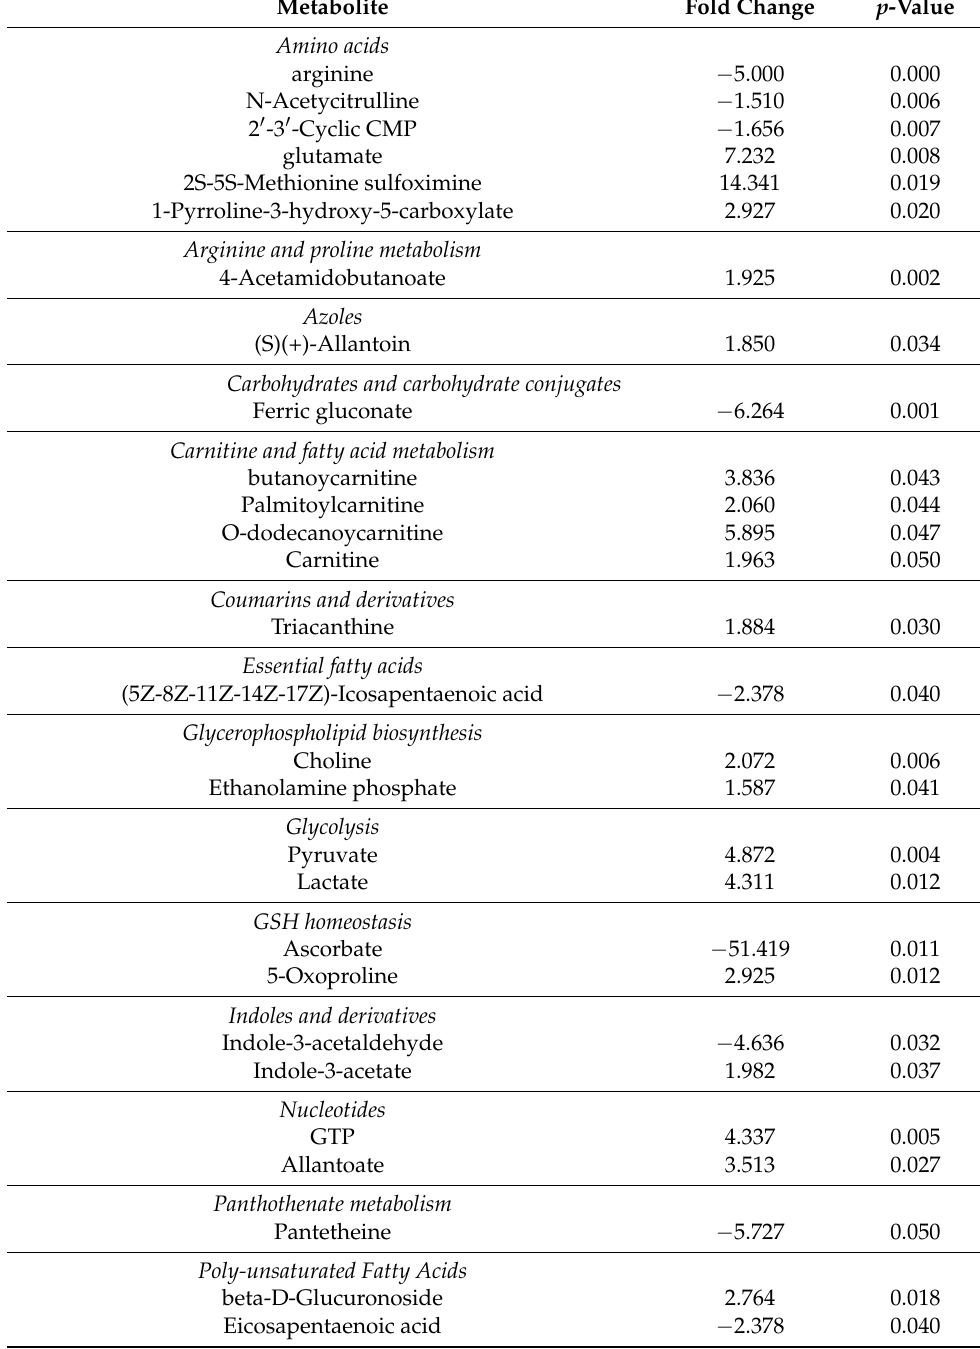
Table 3. List of all differentially expressed metabolites in BVNF versus SVHF sera, classified by each implicated pathway.